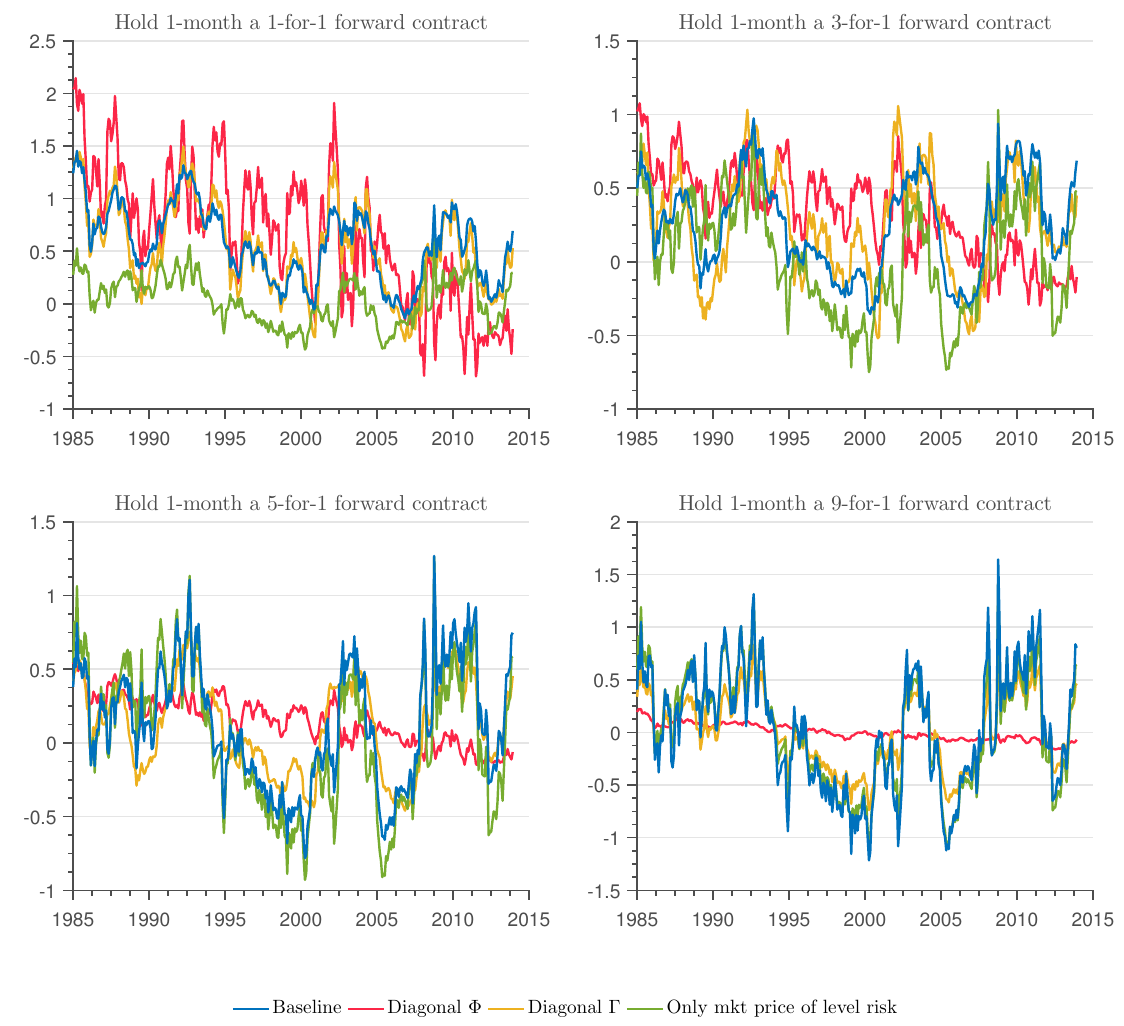
Figure 8. One-month holding forward risk